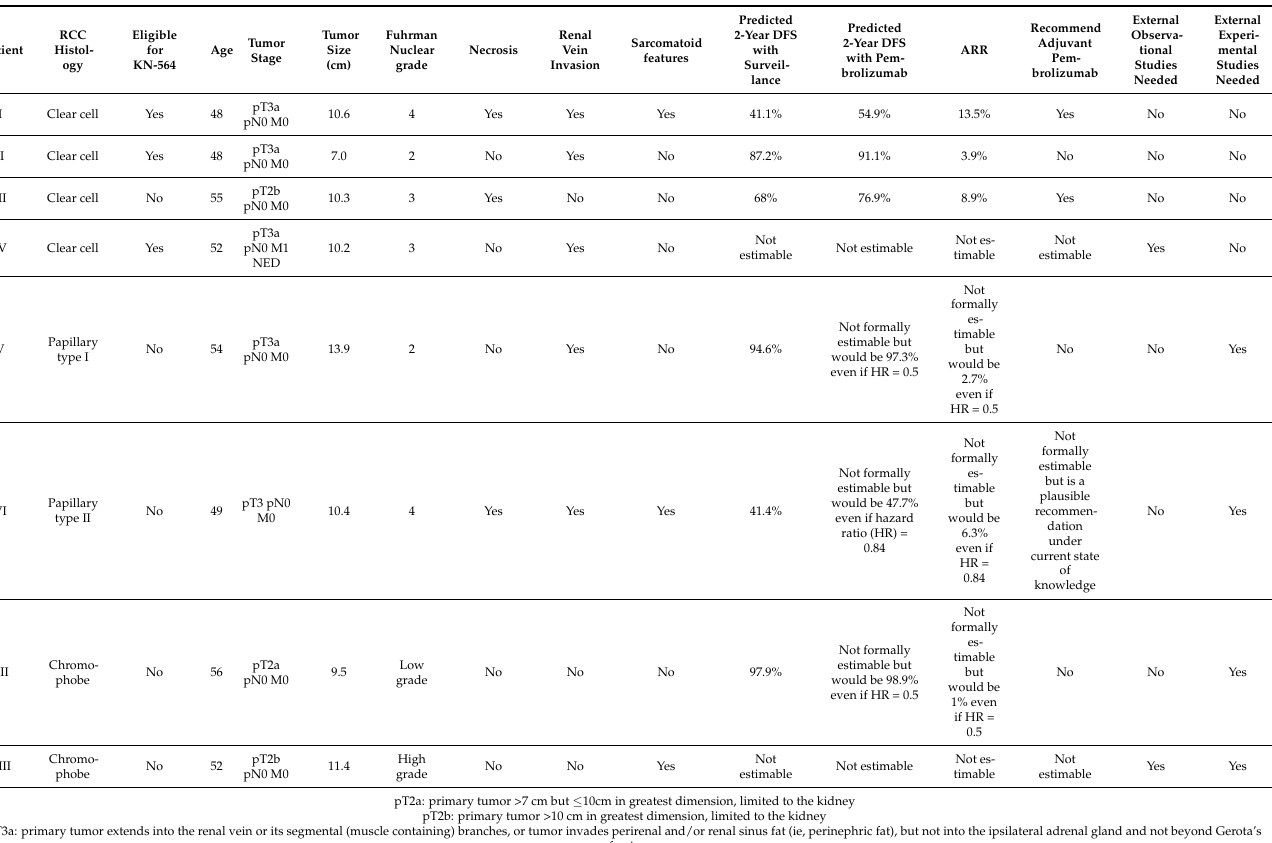
Table 4. Patient-specific inferences and research design recommendations in eight clinical scenarios where adjuvant pembrolizumab is considered, based on KEYNOTE-564 (KN-564) [9] in patients harboring one of the three most common renal cell carcinomas (RCC). All patients are otherwise healthy and are interested in an absolute risk reduction (ARR) of at least 5% in two-year DFS probability with adjuvant pembrolizumab as estimated using the Assure prognostic nomogram